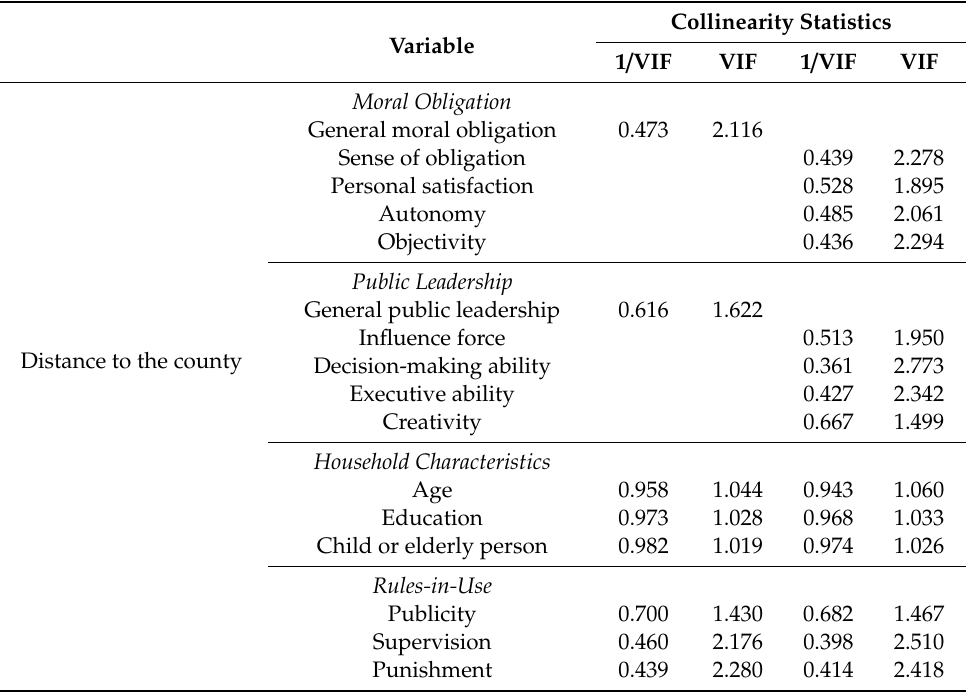
Table 3. Multicollinearity